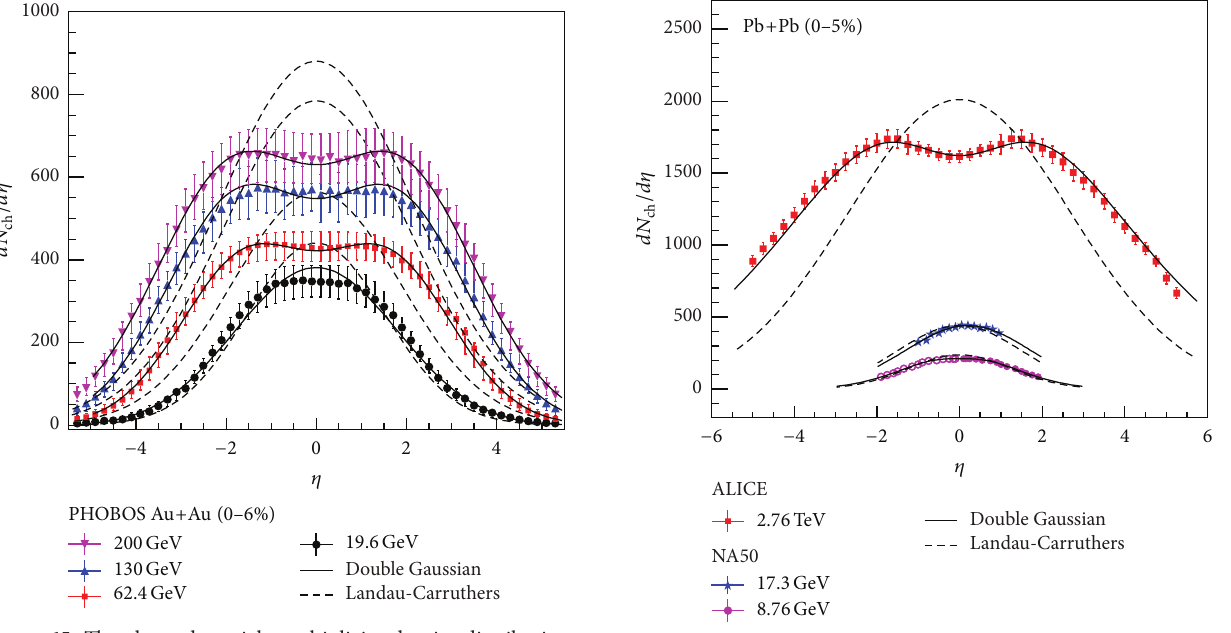
Figure 16: The charged particle multiplicity density distributions of Pb+Pb collisions at three different energies, fitted with double Gaussian function and Landau-Carruthers functions.